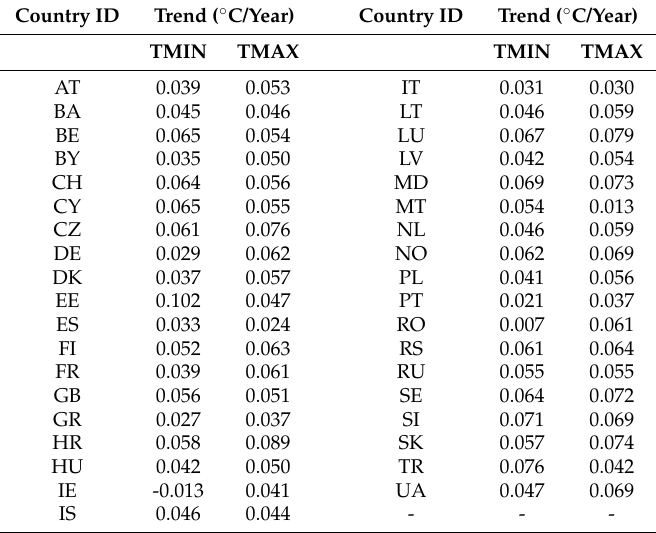
Table 7. Trends ( ◦ C/year) for the minimum and maximum temperatures and all the countries, estimated by the GAM